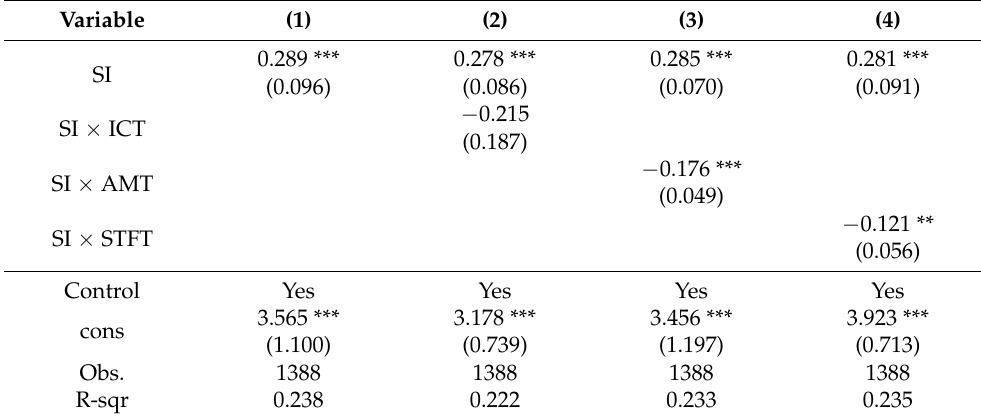
Figure 4. Heterogeneity in the moderating effects of the adoption of the three technologies. Table 7. Effects of technology adoption.